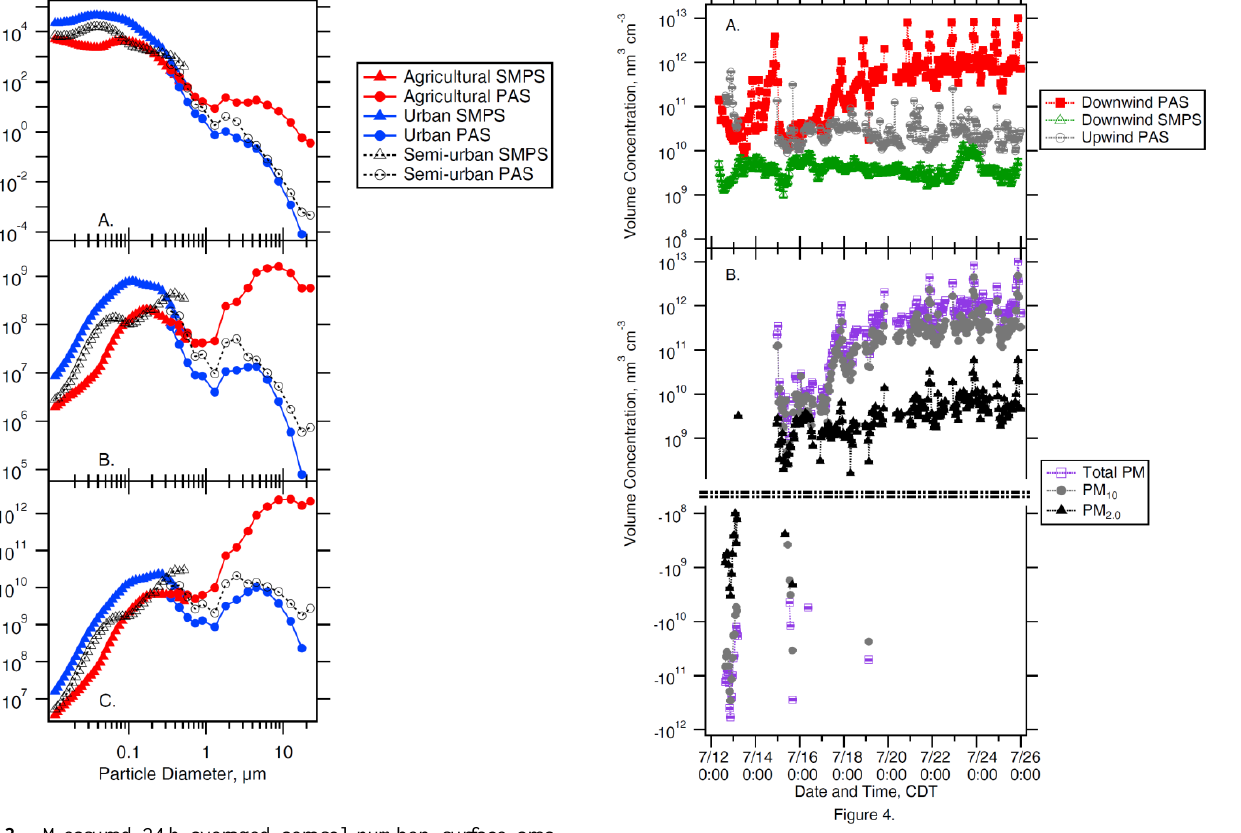
Fig. 4. In (A) , hourly averaged volume concentrations of particulate matter measured by the PAS and the SMPS at the nominal down- wind site and by the PAS at the upwind site are shown as solid red squares, open green triangles, and open grey circles, respectively. In (B) , background corrected feedlot volume concentrations of the to- tal particles sampled by the PAS, of particles ≤ 10µm diameter, and of particles ≤ 2.0 diameter are shown as open purple squares, solid grey circles, and solid black triangles, respectively. Error bars rep- resent measurement uncertainties of ± 17% and ± 3% for the SMPS and PAS, respectively. Note that (B) is plotted with a break in the y-axis to emphasis the fact that at low concentrations, variability in volume concentration spans several orders of